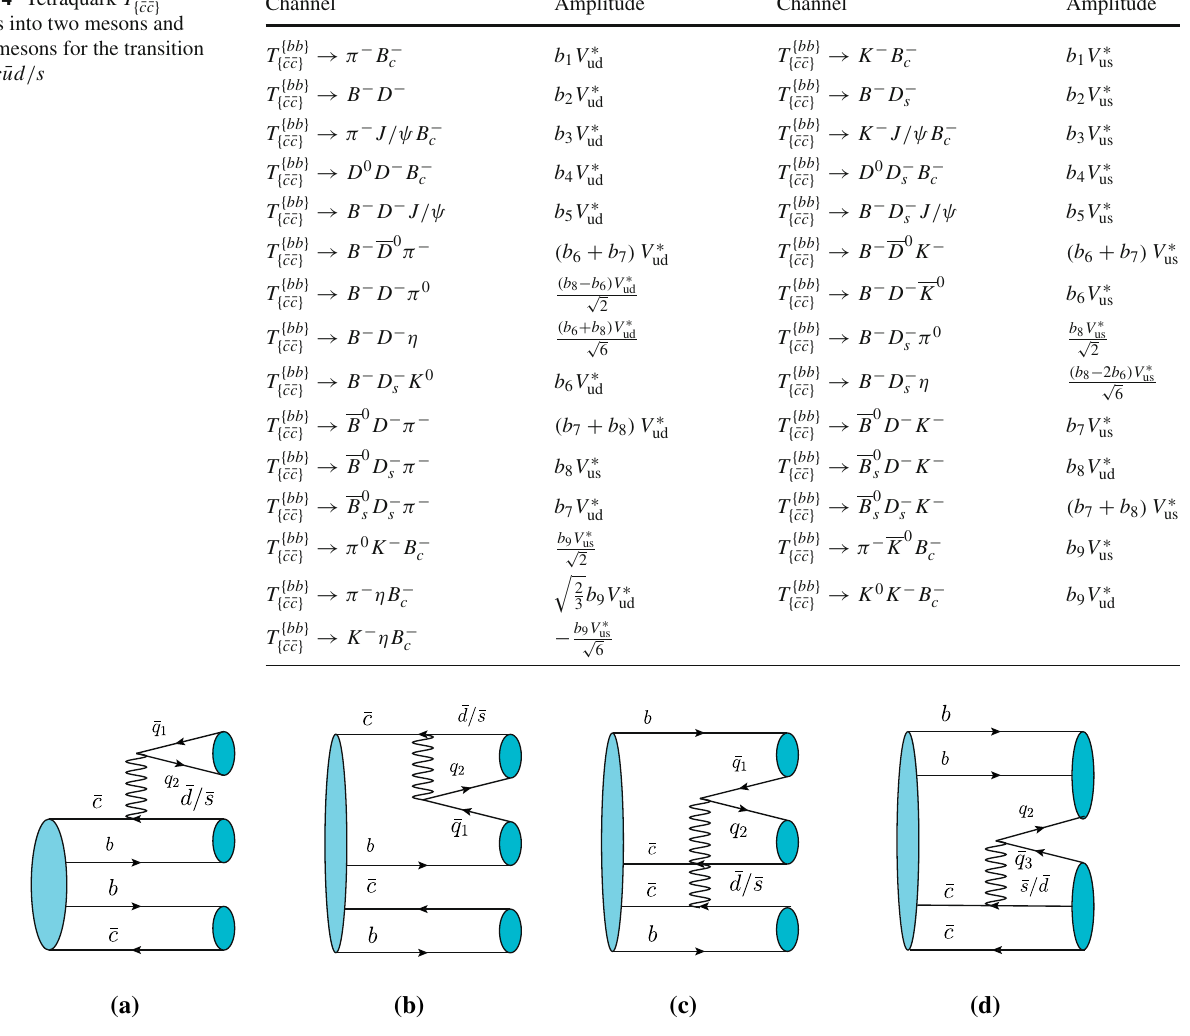
{ bb } Fig. 5 The Feynman diagrams for T {¯ c ¯ c } non-leptonic decays within mesonic decays shown in panels a – c and two-body baryonic decays given in panel d { bb } Table 5 Tetraquark T {¯ c ¯ c } decays into singly charmed baryon plus singly bottom baryon for the transition b → c ¯ ud /